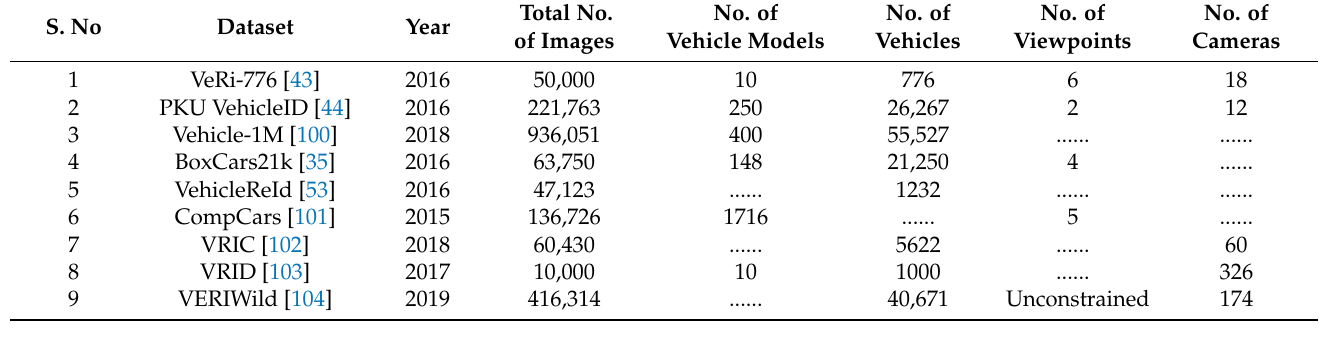
Table 3. Characteristics of publicly available datasets.